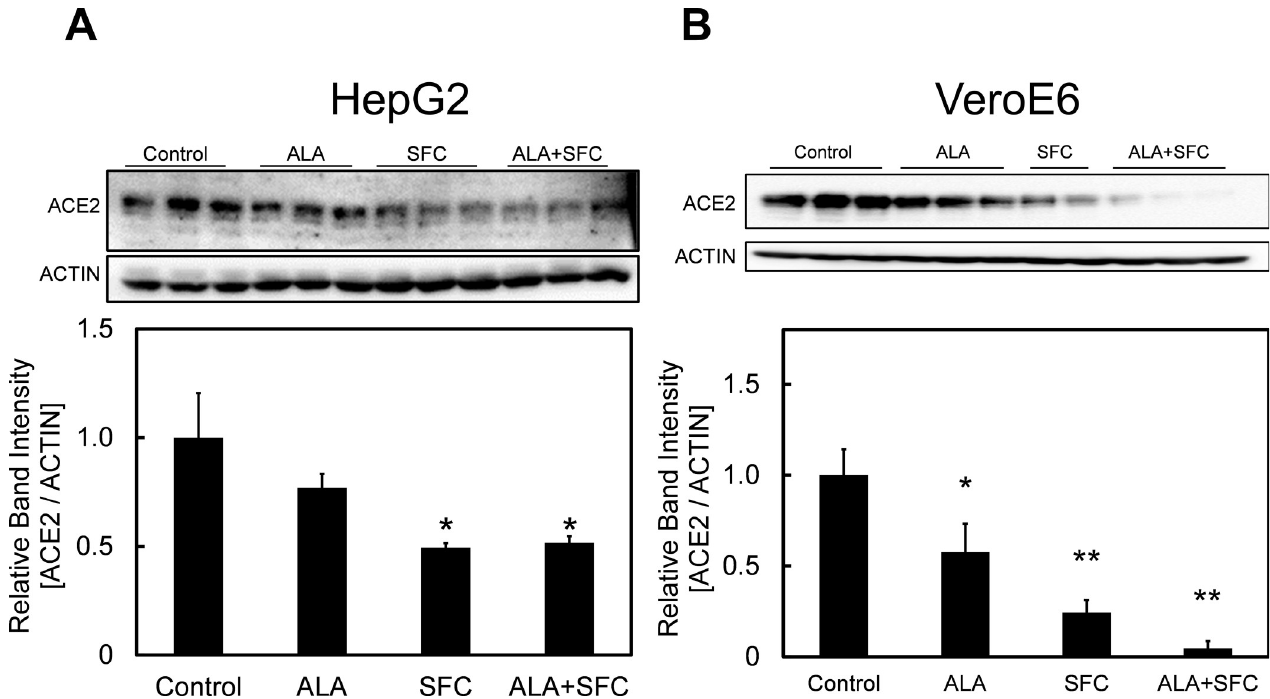
Fig 4. Changes of ACE2 expression following ALA and SFC co-administration. Changes in protein expression levels of ACE2 in (A) HepG2 and (B) VeroE6 cell lines in the presence or absence of ALA and SFC. A one-way ANOVA (Tukey’s test) was performed for each data set to identify differences in mean values between treated and untreated samples; �� , p < 0.01; � , p < 0.05. n = 3 or 2. Bars represent standard deviation (SD). Blots are cropped to ease visualization. Unprocessed original blot scans are shown in S2 Fig.